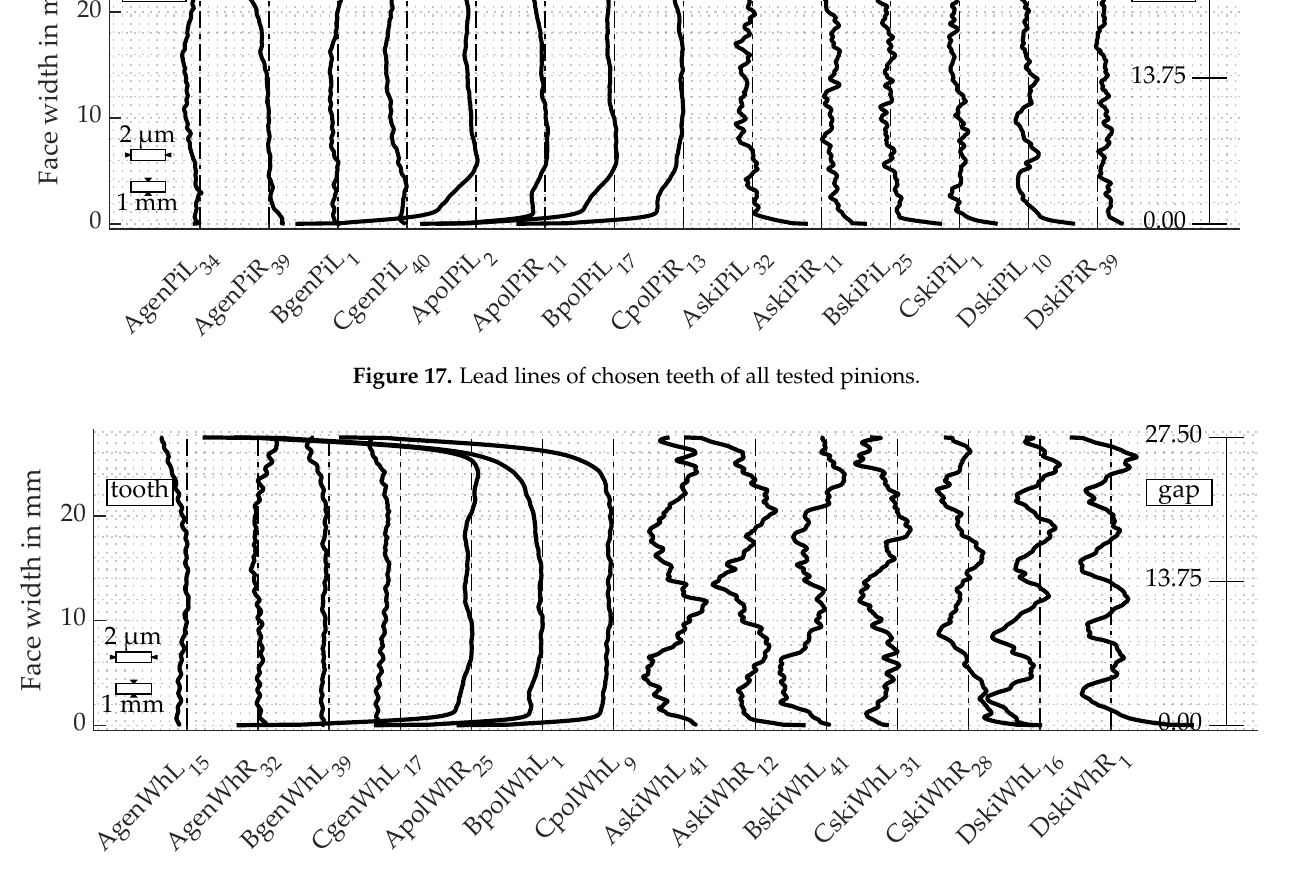
Figure 18. Lead lines of chosen teeth of all tested